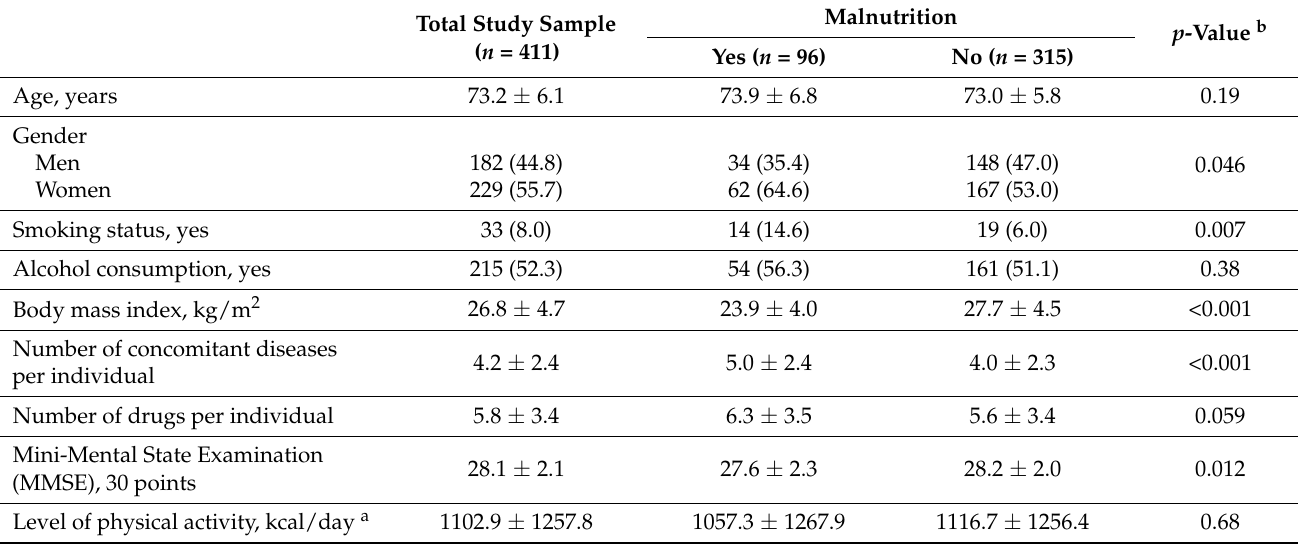
Table 1. Baseline characteristics of participants in the SarcoPhAge study ( n = 411).